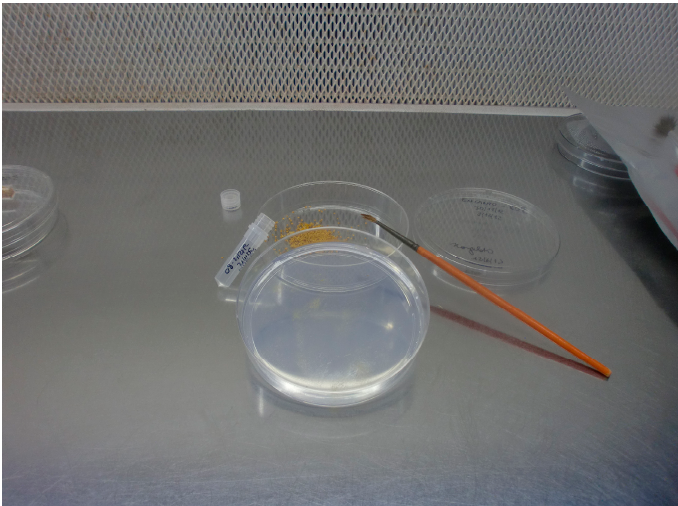
Figure 1. Example of rose anthers stored at low temperatures for conservation trials. Over the storage period, germination readings were made by immediately spreading pollen with a paint brush on a Petri dish filled with the culture medium. Reproduced from Giovannini et al. (2015) [6], with permission of ISHS.